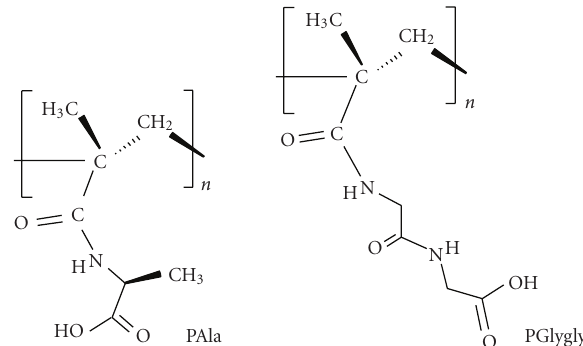
Scheme 1: The polyelectrolytes poly-N-methacryloyl-L-alanine (PAla) and poly-N-methacryloyl-glycylglycine